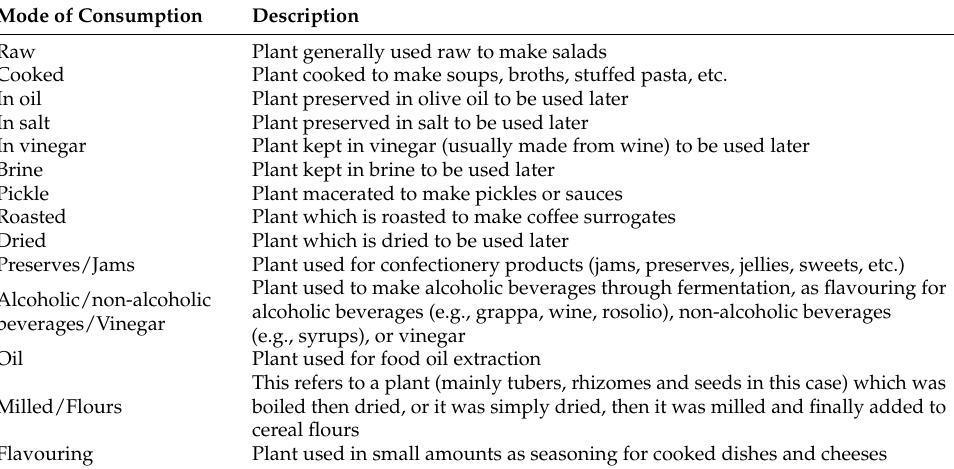
Table 2. Mode of